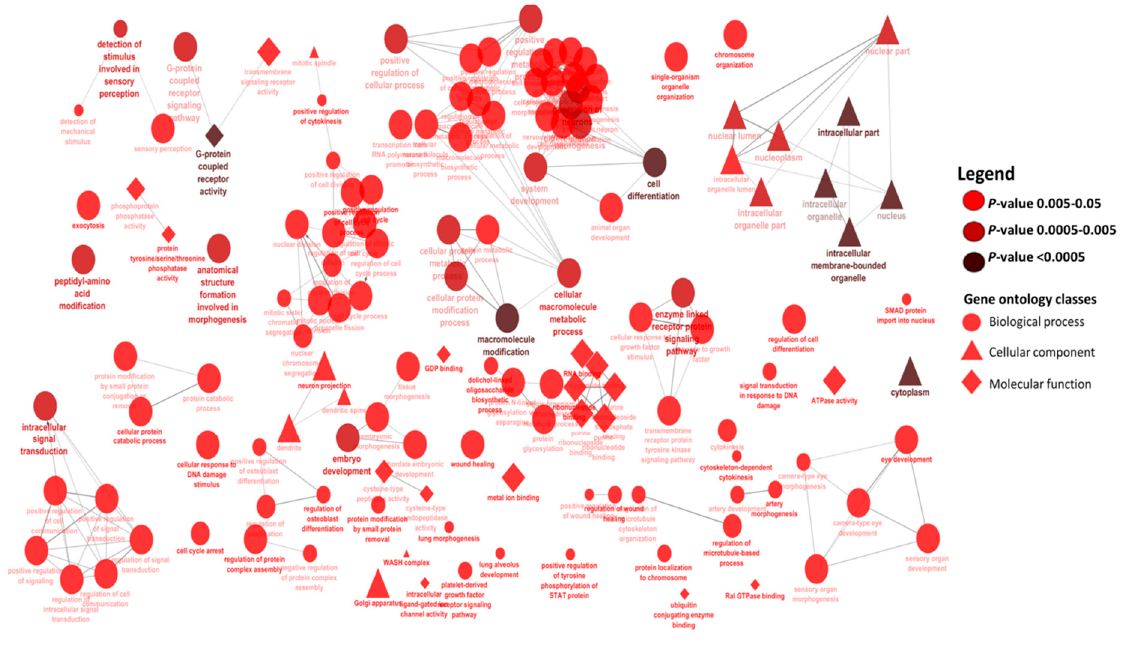
Figure 4. Enriched gene ontology terms for target genes of miRNAs in the GREEN module. The round, triangle and diamond shapes present biological process, cellular component and molecular function gene ontology terms,